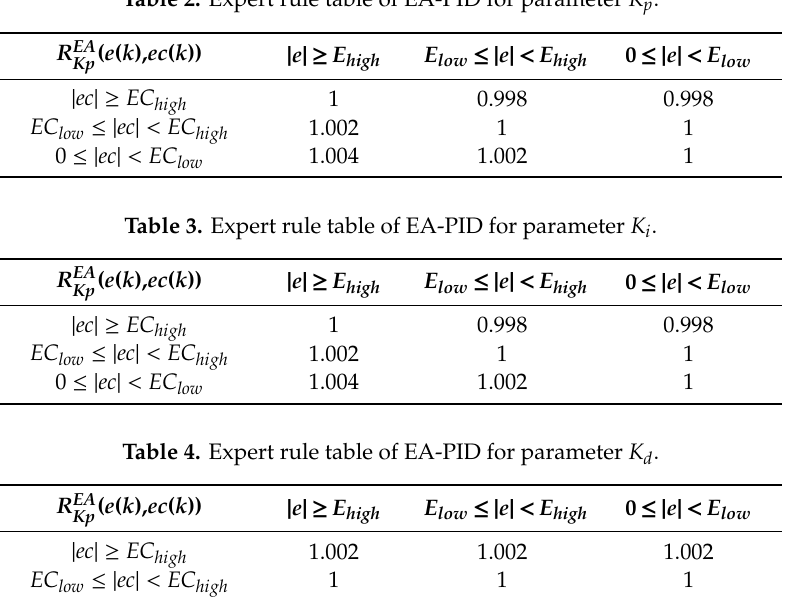
Table 2. Expert rule table of EA-PID for parameter K p .